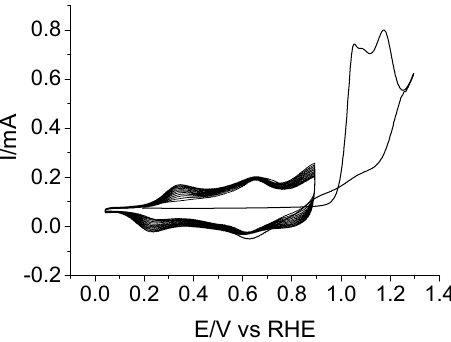
Figure 3. Cyclic voltammograms recorded for a Pt electrode during the electrochemical copolymerization of 0.5 M of piperazine and 0.1 M of aniline in 1 M of HClO 4 solution. The upper potential limit was set at 1.3 V for the first scan, and at 0.9 V for the subsequent ones. v = 50 mV s − 1